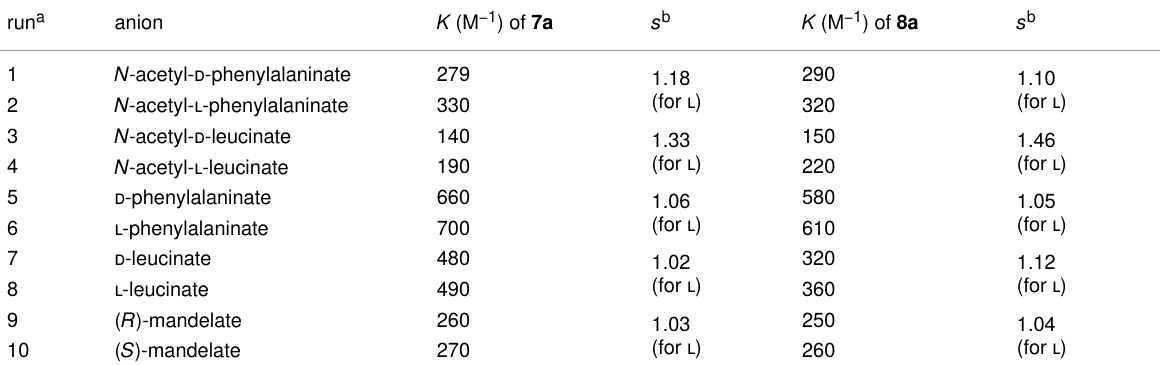
Table 1: Binding constants of the receptors 7a and 8a towards selected anions ( 1 H NMR titration, 400 MHz, DMSO- d 6 , 298 K). run a